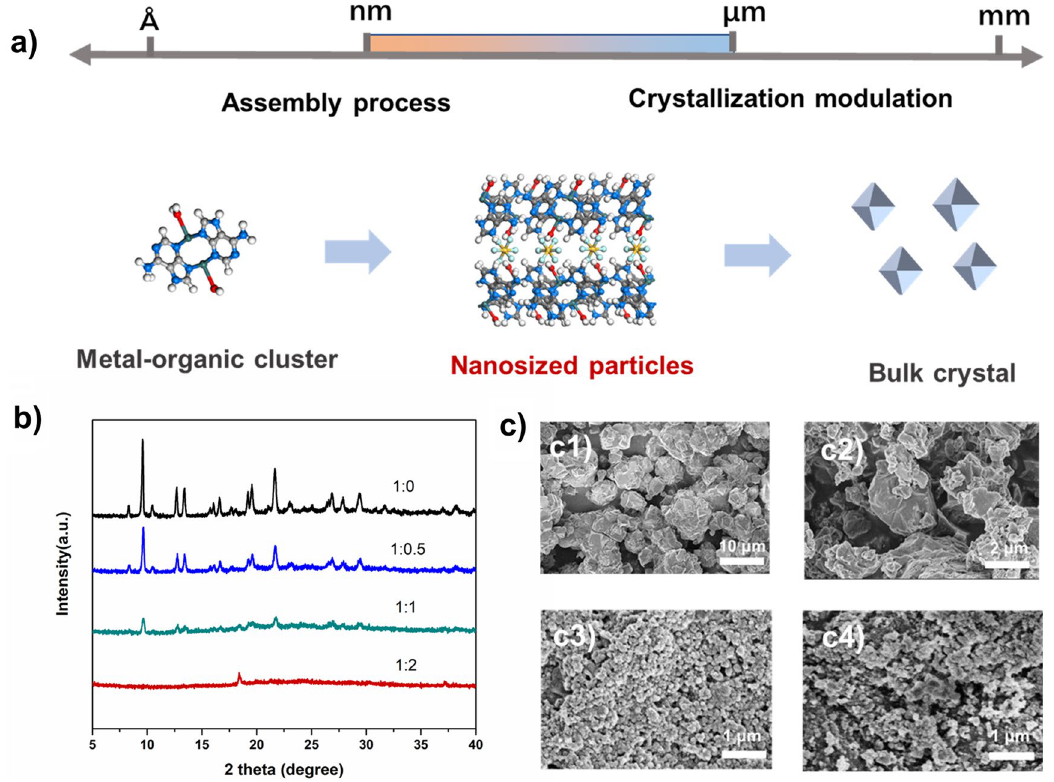
Fig. 1 a Schematic of HOF-21 frame construction. b XRD patterns of HOF-21 prepared by different ratios of (NH4) 2 SiF 6 /diethylamine. c SEM images of HOF-21m ( c1 ) and HOF-21n with different ratios of (NH4) 2 SiF 6 /diethylamine ( c2 for the ratio of 1:0.5, c3 for the ratio of 1:1, c4 for the ratio of